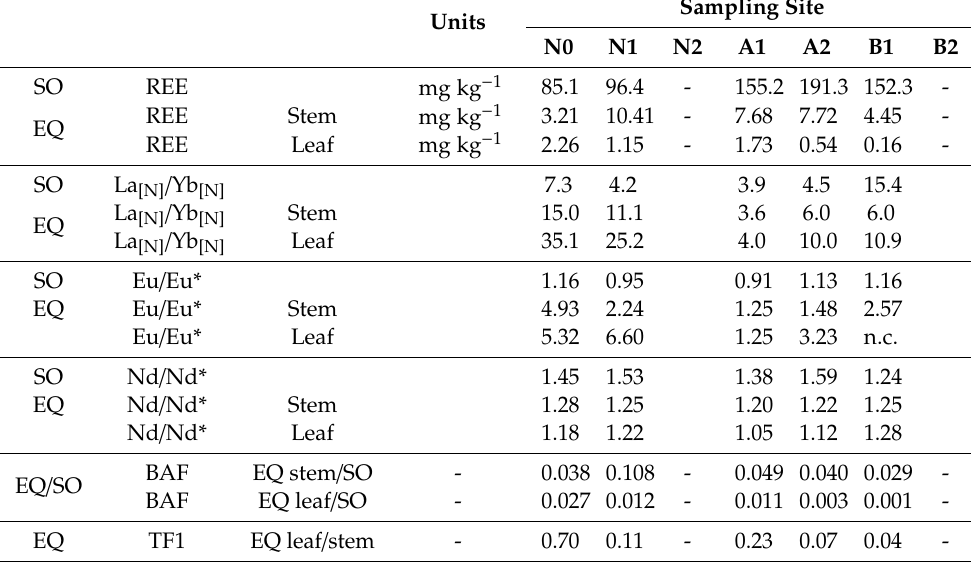
Table 1. REE contents, La [N] / Yb [N] fractionation factors, and Eu / Eu* and Nd / Nd* ratios of soil (SO) and the aerial parts (stems and leaves) of the plant Equisetum arvense L. (EQ). The bioaccumulation factors (BAFs) were obtained through the ratio of the REE content in plant parts divided by the soil content, and the translocation factors (TF1s) in the plant were obtained by dividing the leaf REE content by the stem REE content. The REE content for each sampling site and element can be consulted in the Table S1.